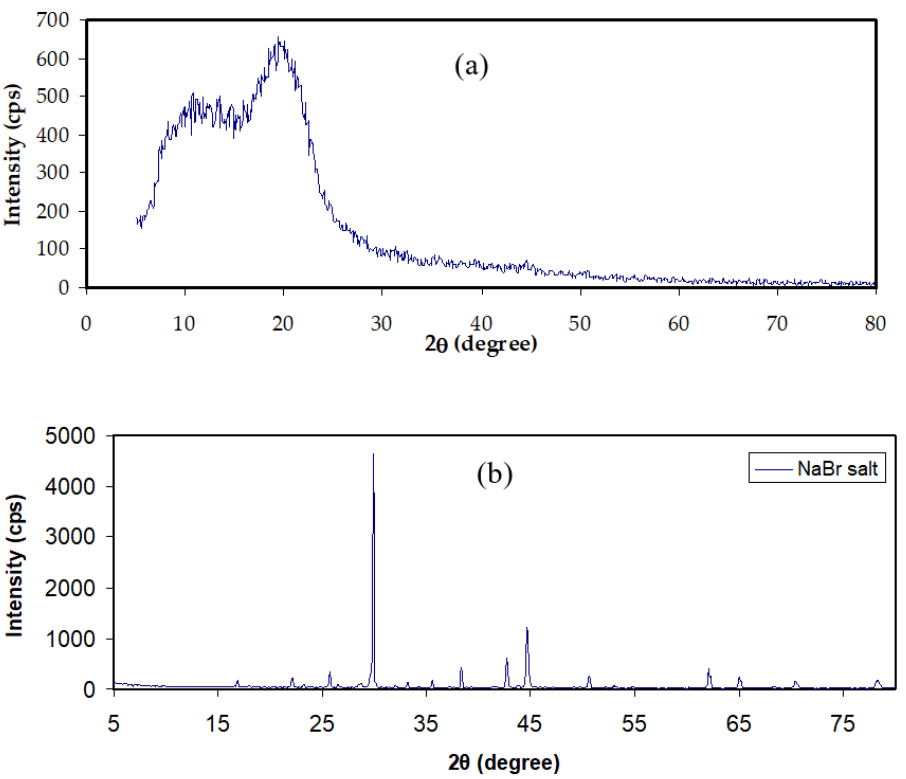
Figure 2. XRD pattern of ( a ) neat MC film and ( b ) NaBr salt.